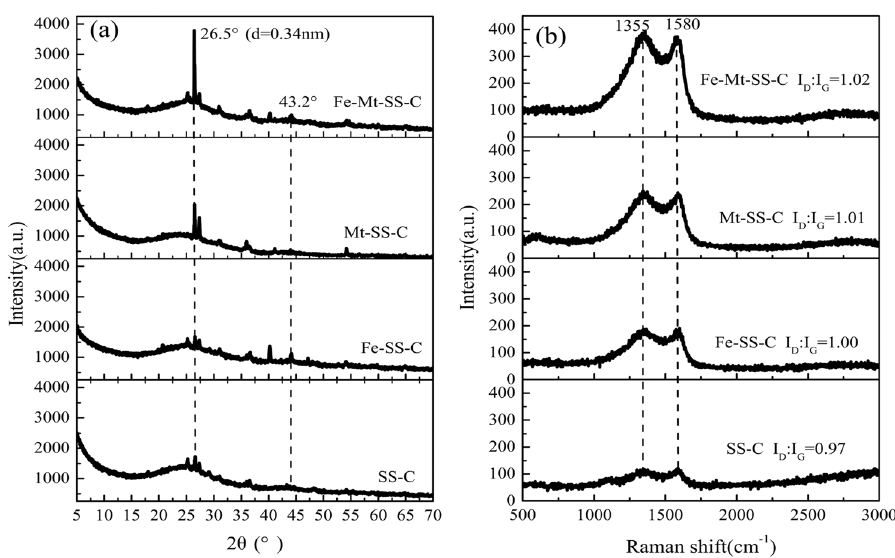
Figure 3. ( a ) XRD patterns and ( b ) Raman spectra of SS-C, Fe-SS-C, Mt-SS-C and Fe-Mt-SS-C,